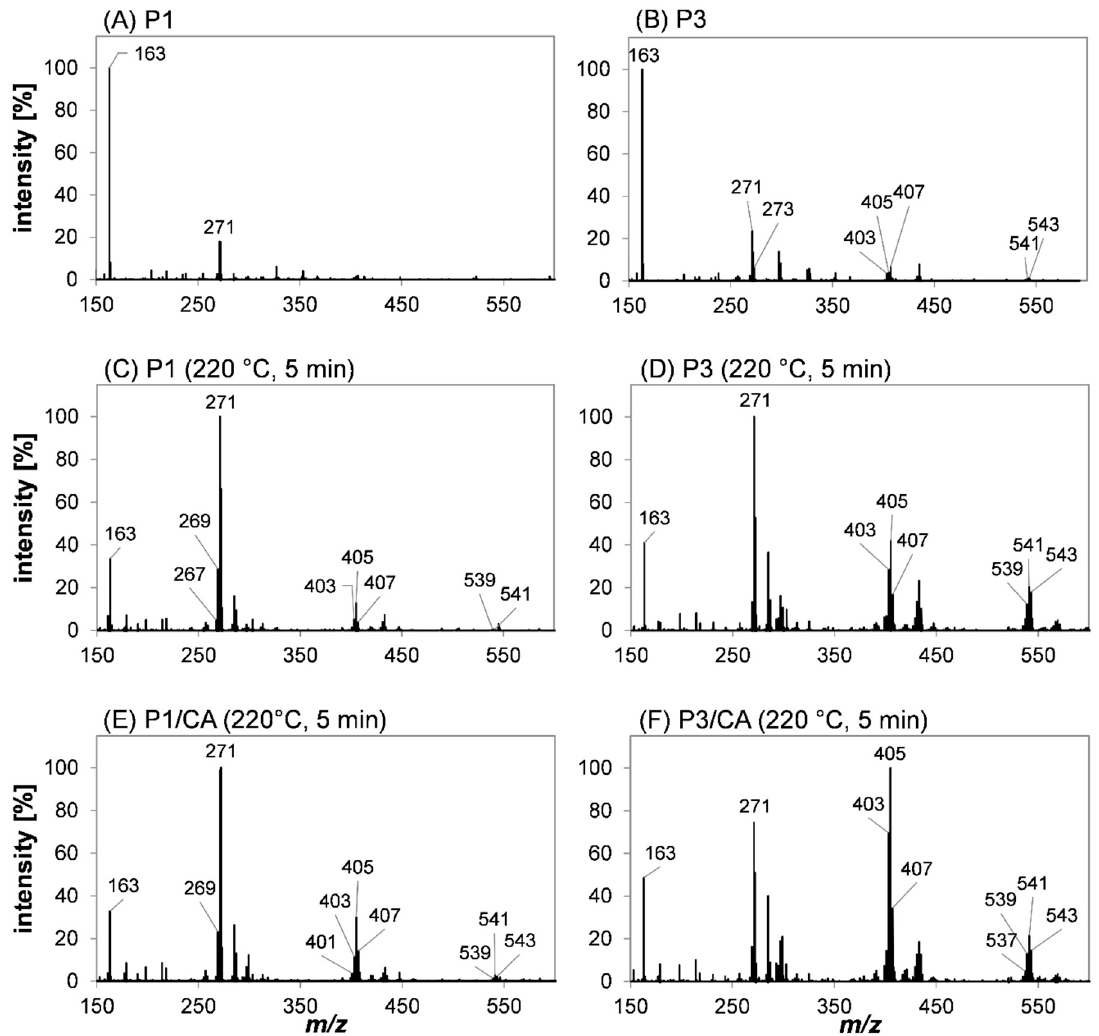
Figure 7. HRMS scan spectra of ( A ) P1 and ( B ) P3 before heat treatment, as well as ( C ) P1, ( D ) P3, ( E ) P1/CA, and ( F ) P3/CA after heat treatment for 5 min at 220 °C using an APCI-orbitrap-MS instrument in positive ion mode. Mass spectra were modified by removing the signal of the solvent (dimer of ethylacetate) and re-referencing the intensity of all signals accordingly. A scan spectrum of the solvent is attached and can be found in the supplementary material (Figure S1).